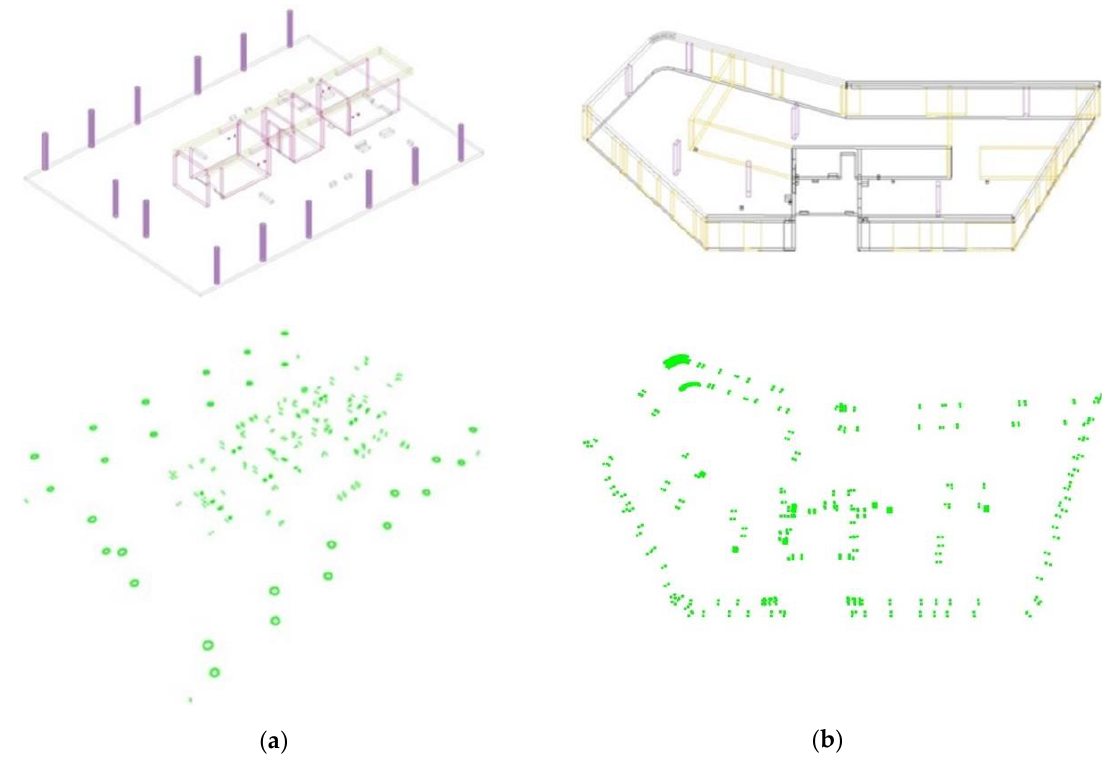
Figure 4. IFC elements vertices extraction: ( a ) IFC SQVERAS data to point cloud, and ( b ) IFC A1 data to point cloud.